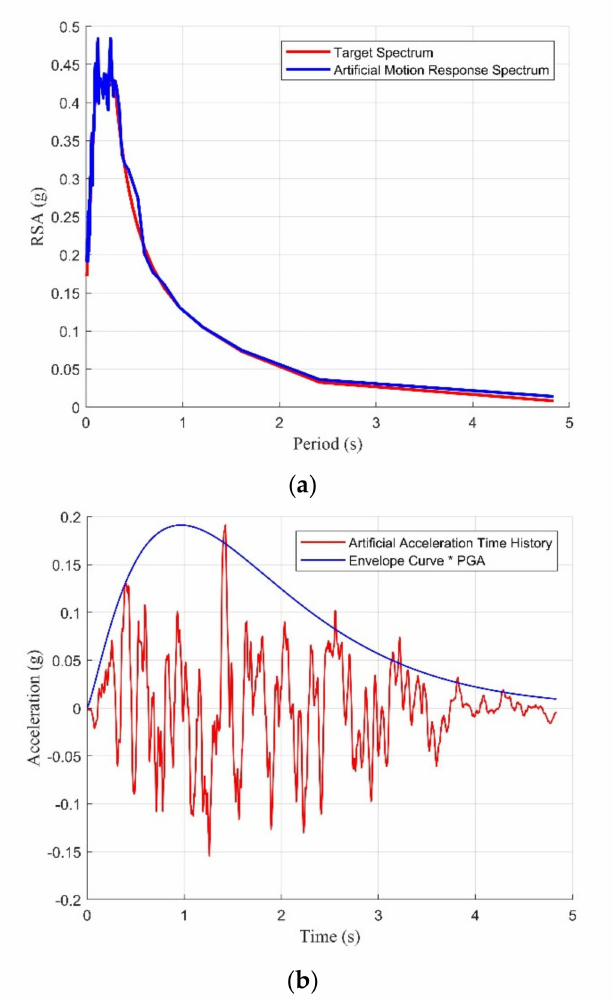
Figure A4. Demonstration of an artificial ground motion accelerogram: ( a ) acceleration response spectrum; ( b ) acceleration time